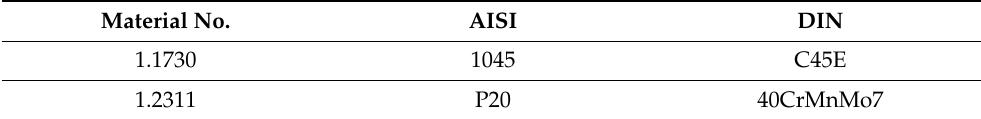
Table 2. Tool steels used to calculate machining time. Material